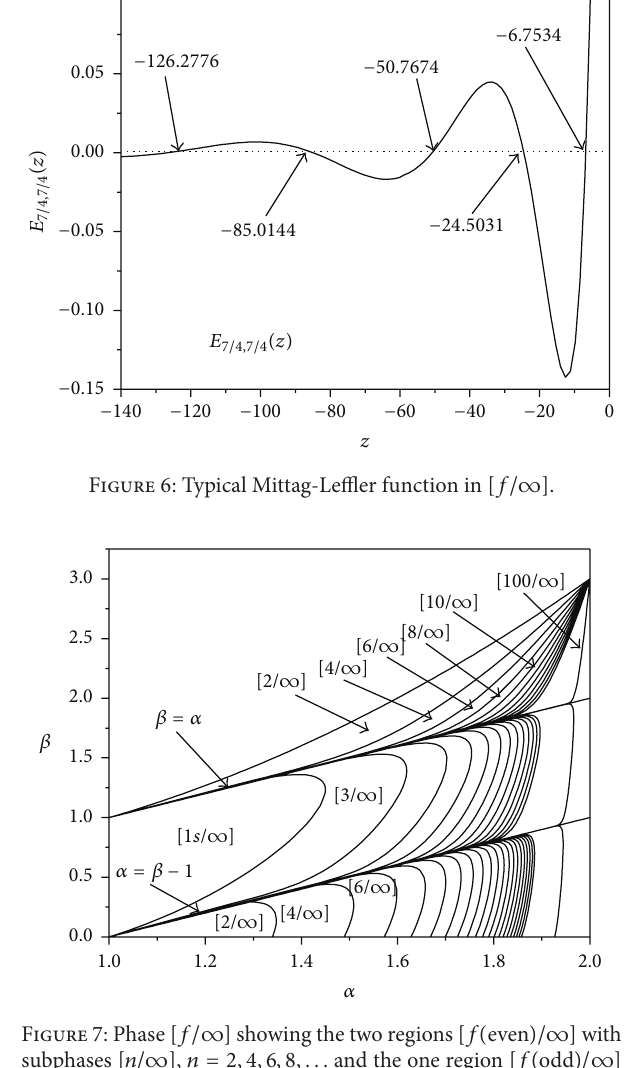
Figure 7: Phase [ 𝑓/∞ ] showing the two regions [ 𝑓( even )/∞ ] with subphases [ 𝑛/∞ ], 𝑛 = 2, 4, 6,8, . .. and the one region [ 𝑓( odd )/∞ ] with subphases [𝑛/∞] , 𝑛 = 1,3, 5, 7,. . . .